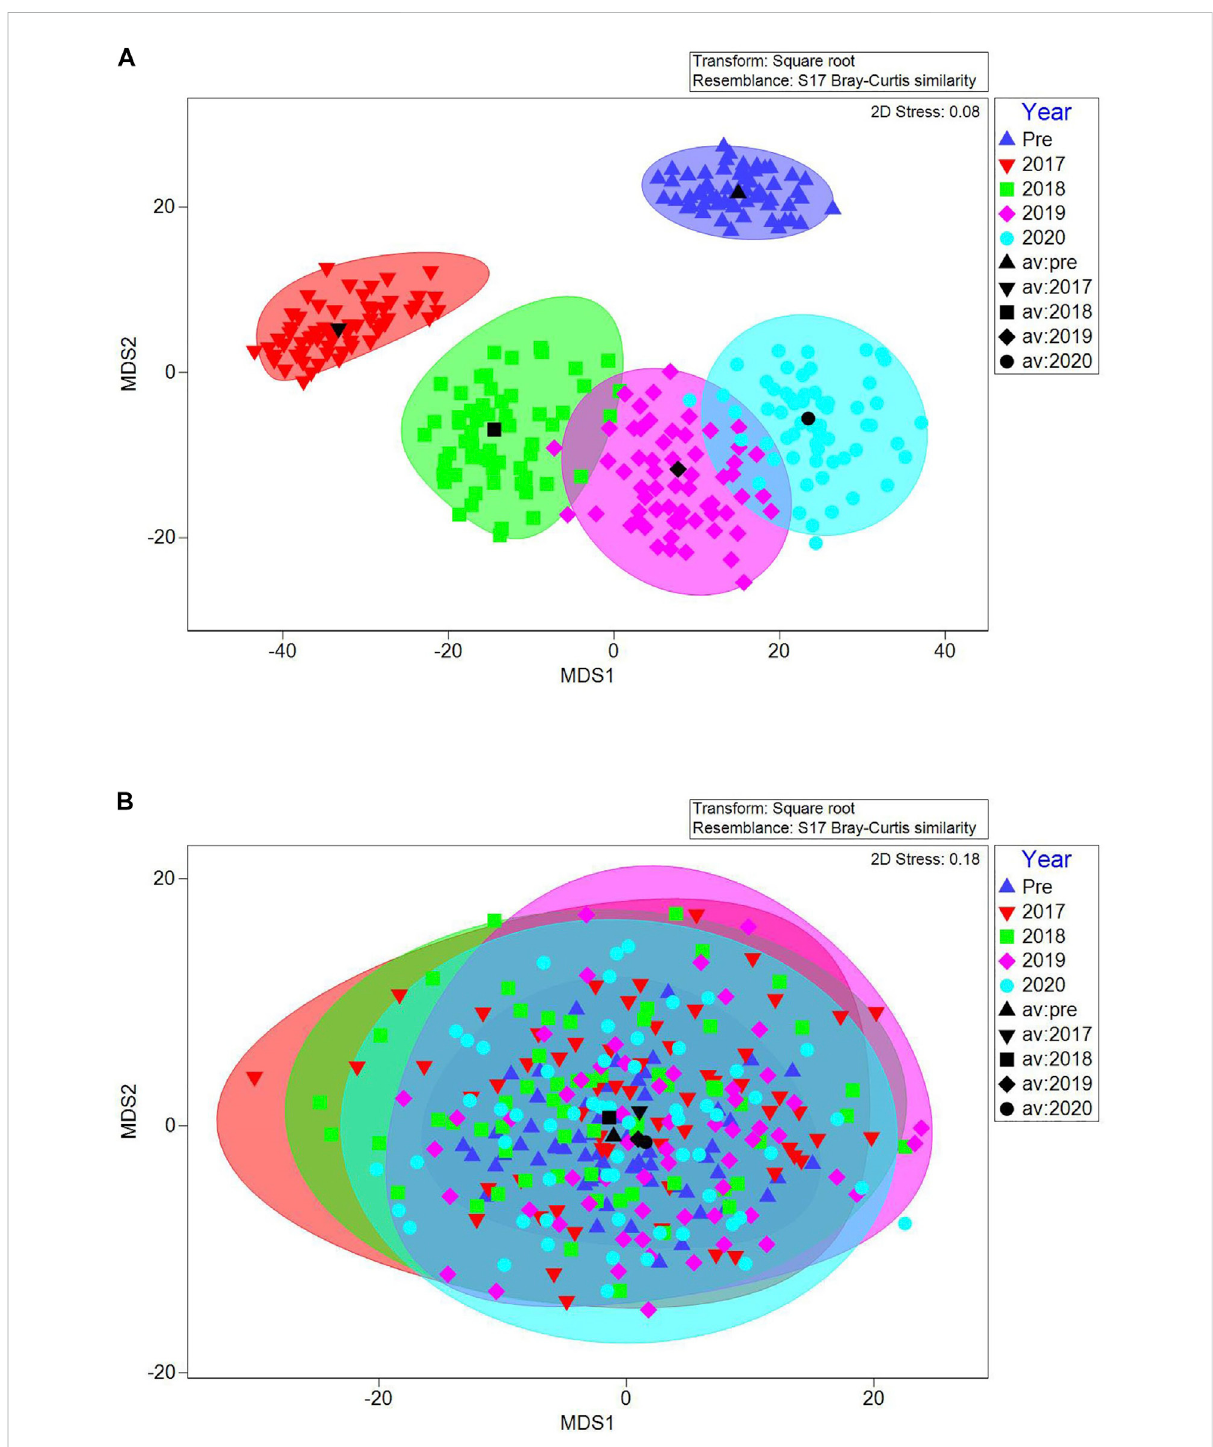
FIGURE 6 Metric multidimensional scaling of bootstrap averages for vegetation communities in the impact (A) and control sites (B) over time. Black symbols represent the group average (i.e., the average of the 60 bootstrapped averages) for each year; shaded areas around each group average represent the 95% con fi dence region estimate for each